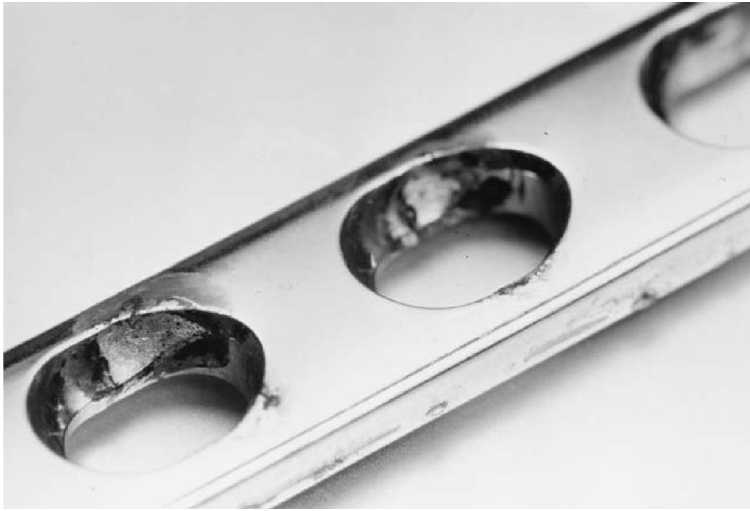
Figure 21. Crevice corrosion in a screw hole in fracture fixation plate [2]. Reprinted with permission from Elsevier.